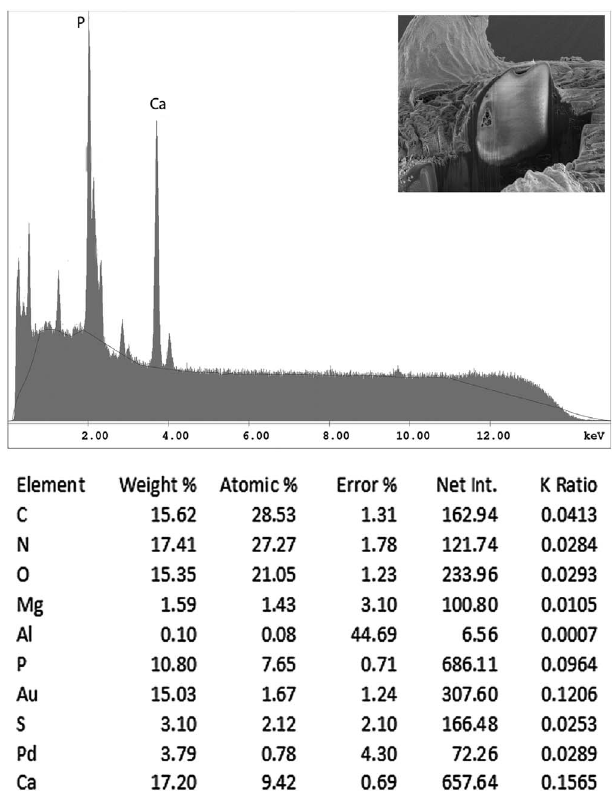
Figure 38. Energy dispersive X-ray spectrum of the small posterior hook of a Neoechinorhynchus personatus specimen from Mugil cephalus in the Mediterranean showing markedly lower levels of phosphorus and calcium, and considerably lower levels of sulfur than anterior hooks (Fig. 37). The X-ray data are the elemental analysis of the whole hook (see bolded fi gures in Table 3). Insert: SEM of a deep Gallium cut at the base of a